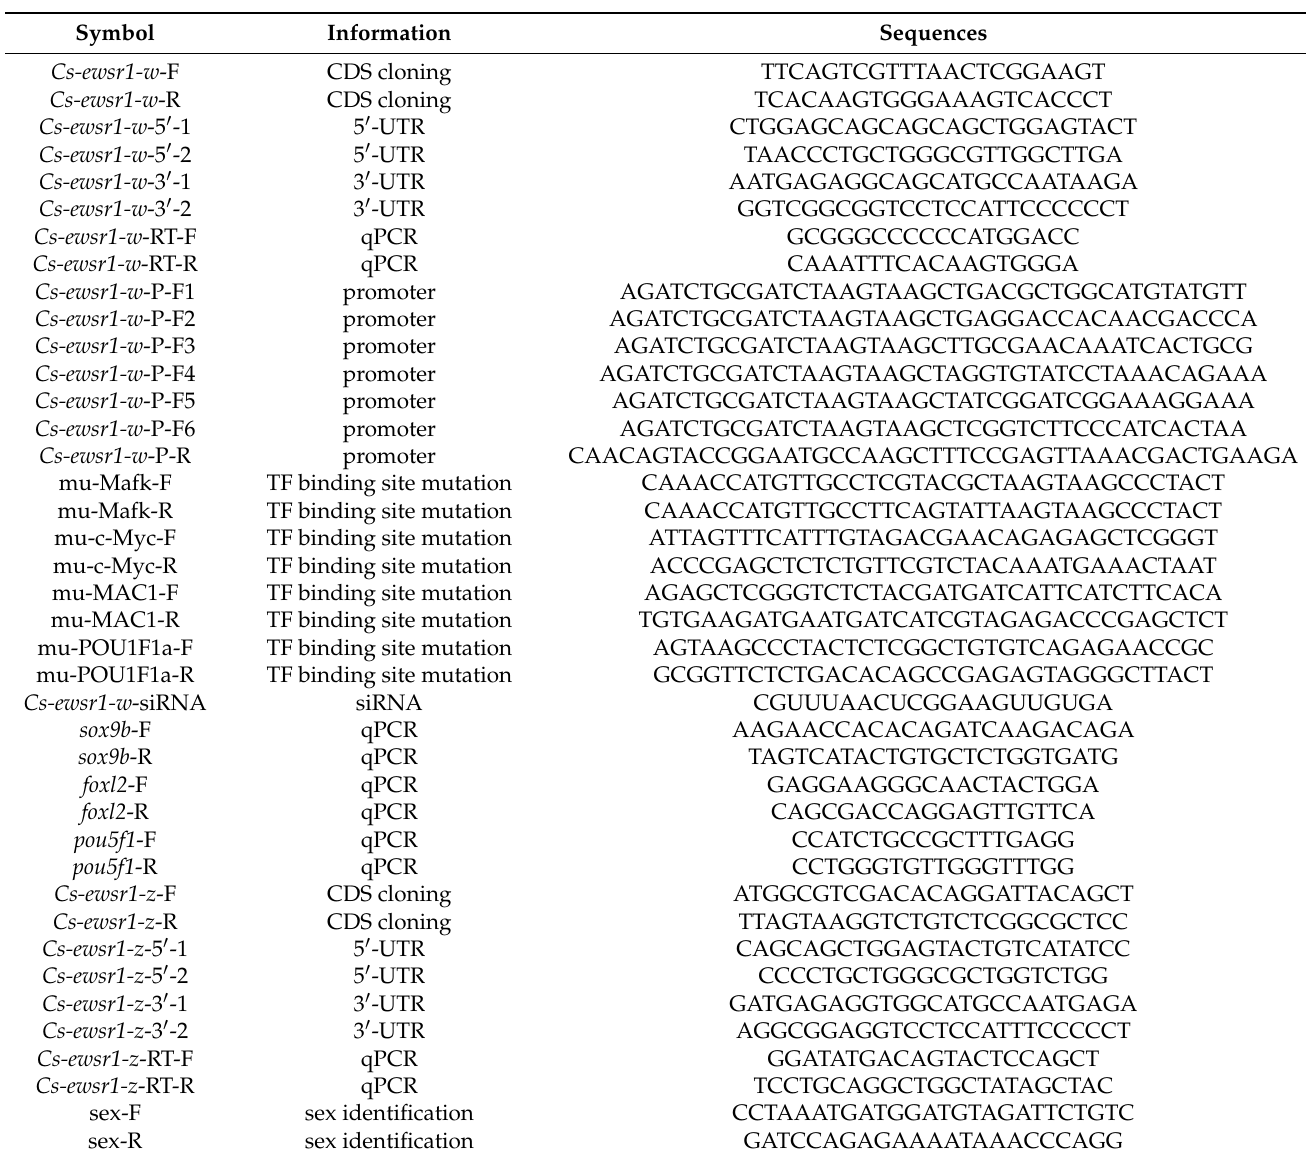
Table 1. All primers used in this